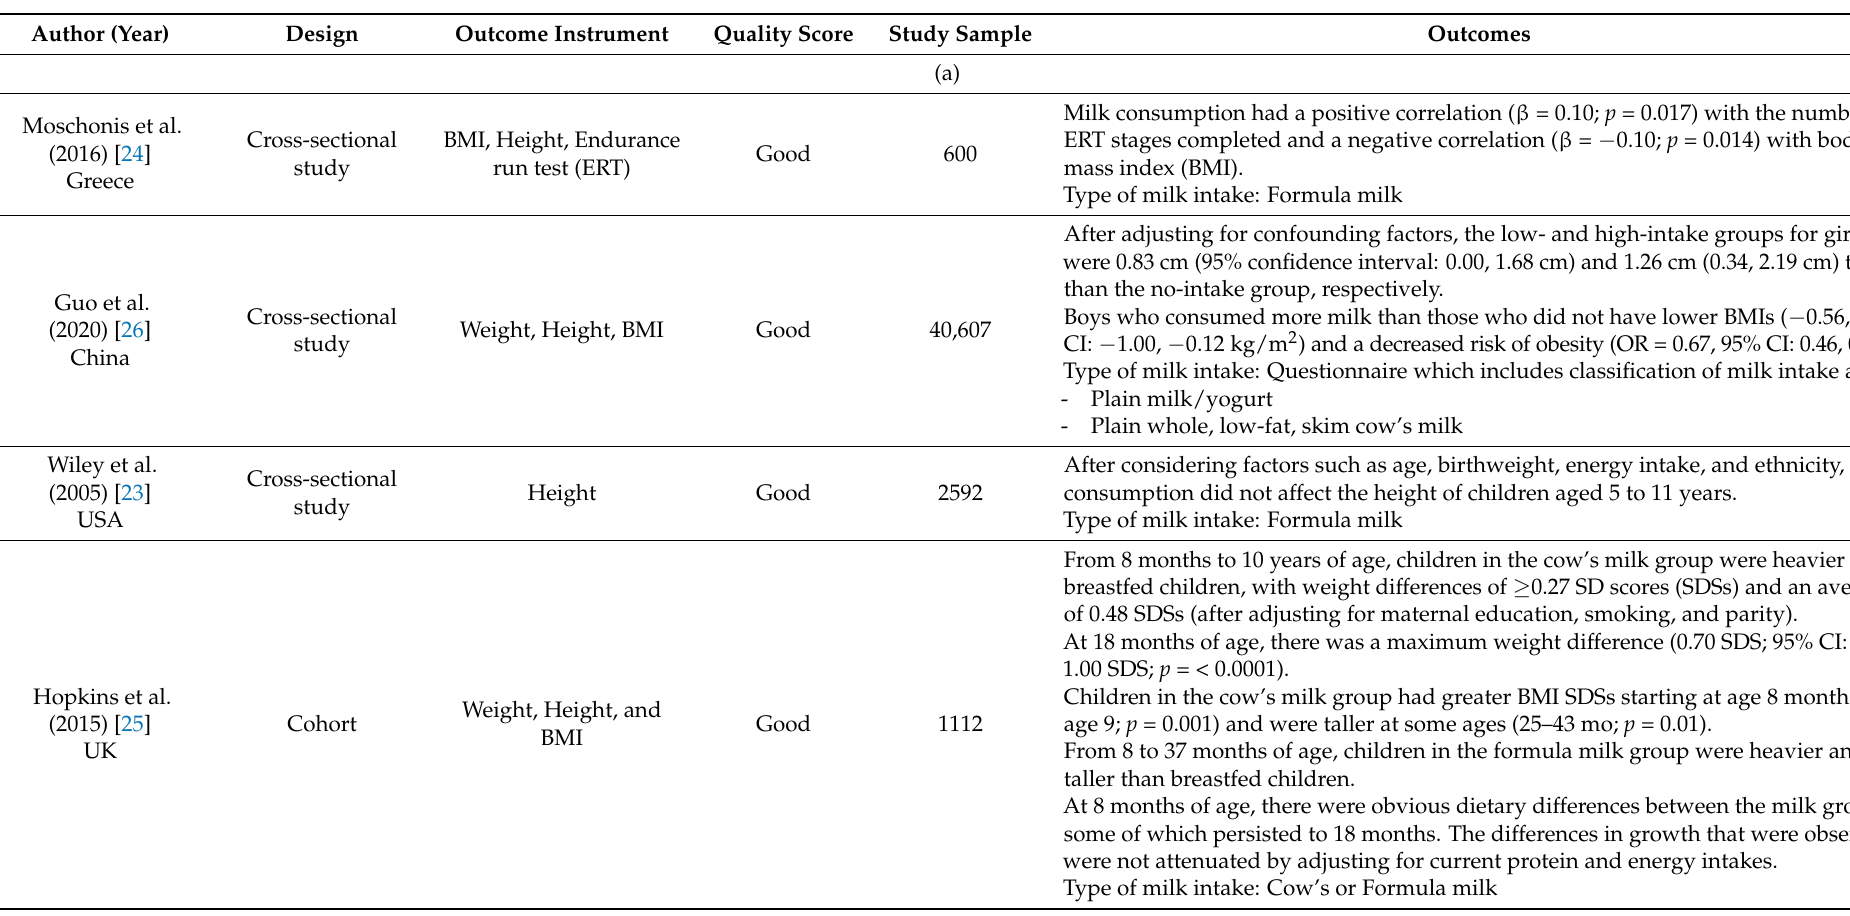
Table 3. ( a ) General characteristics of the studies included and their outcomes for observational studies. ( b ) General characteristics of the studies included and their outcomes for randomised controlled